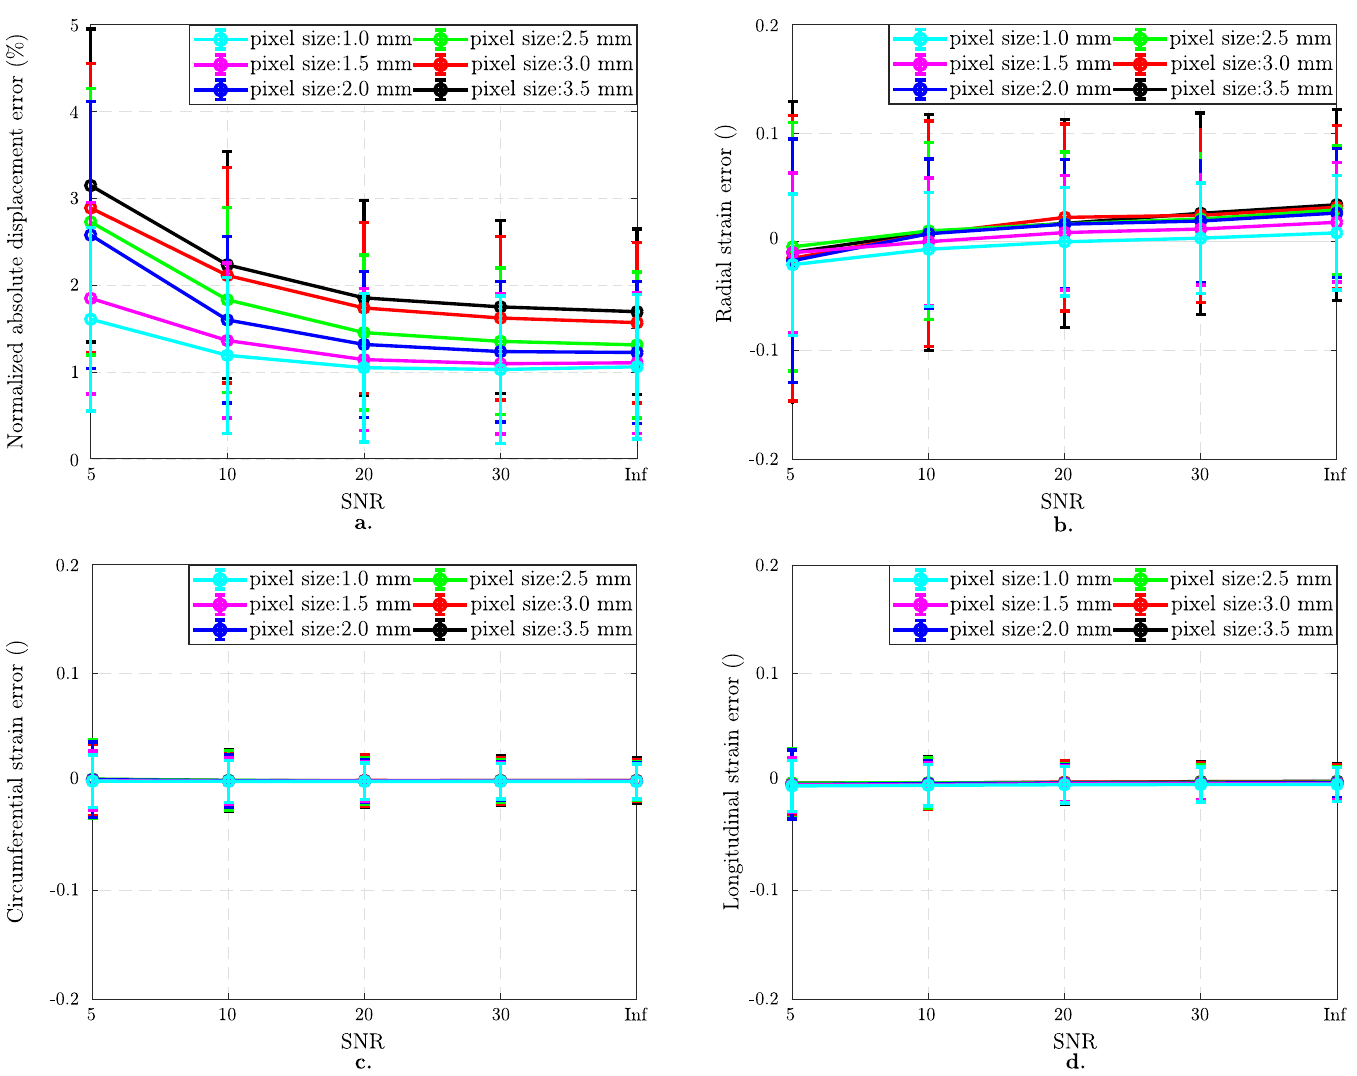
Fig 6. Combined effect of image resolution and SNR on isotropic image analysis. Results on images with 7 mm tag distance. Normalized mean ± standard deviations in displacement error norm (%) plotted as a function of SNR for different pixel sizes (a). Mean ± standard deviations in component-wise Green-Lagrange strain error as a function of SNR and pixel size (b-d). Combined effect of pixel size and SNR is more pronounced on the radial strain component (b) while there is almost no change in the circumferential (c) and longitudinal (d)components. Legends show the pixel size in